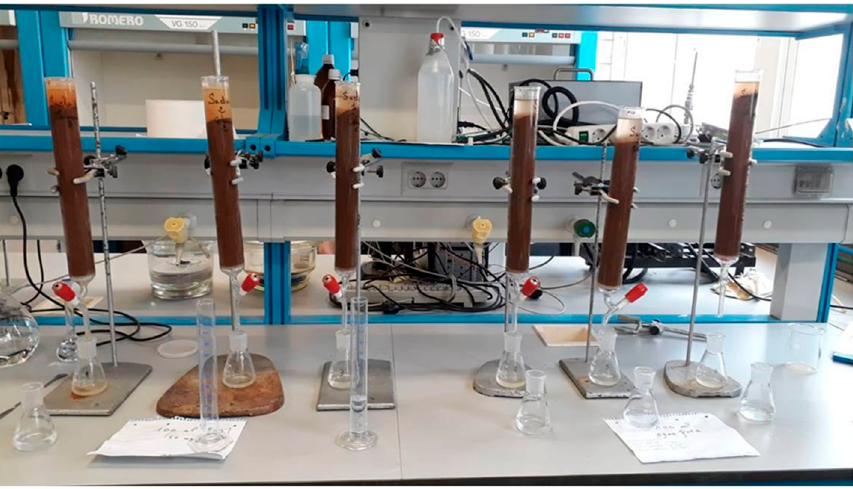
Figure 3. Column setup for the nitrate-leaching experiments of the R’mel soils.